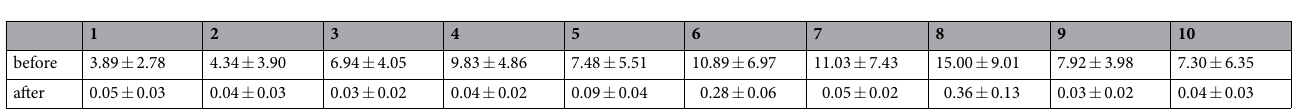
Table 3. Mean 3D Euclidean magnitude distance (unit: mm) for all 3D point sets after registration.